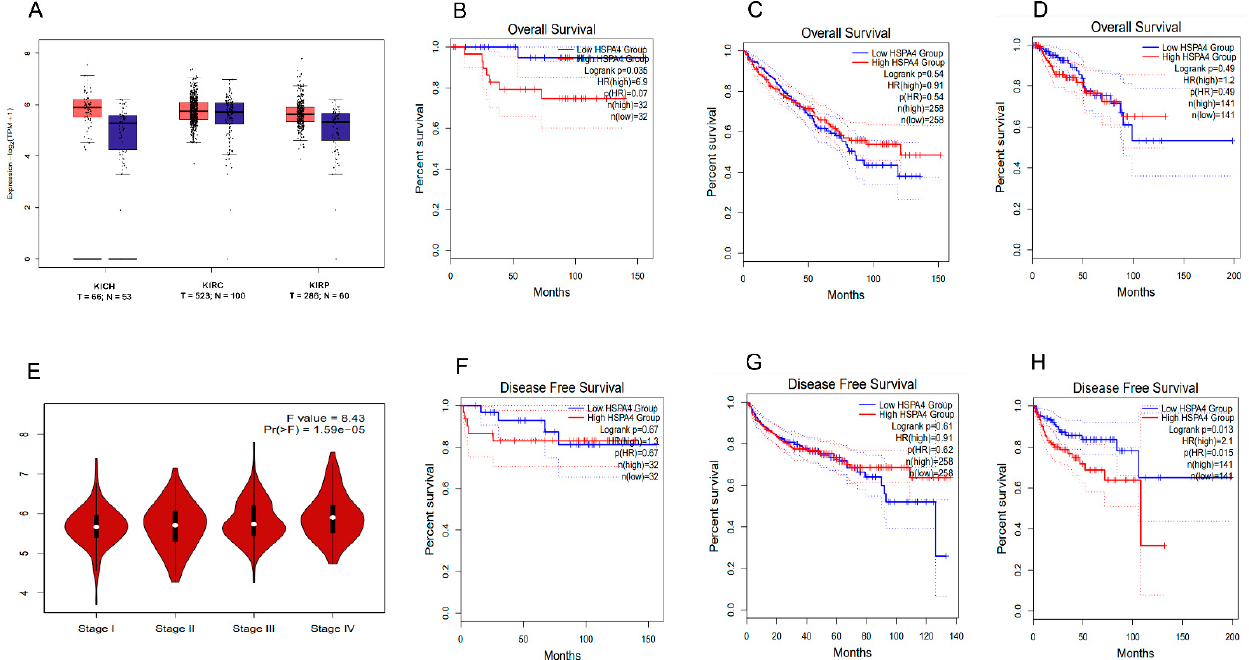
Figure 7. In silico GTEx project and TCGA HSP70 expression analysis ( A ) differential expression of HSP70 in three subtypes of renal cell carcinoma (RCC) tumors (T) compared to normal tissues (N)